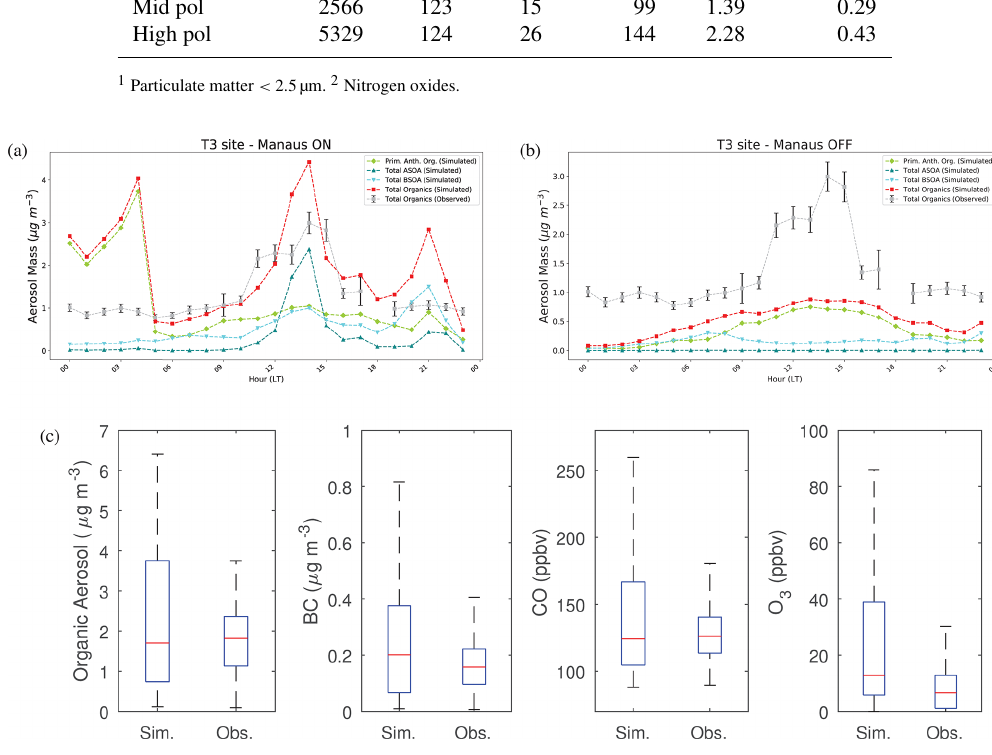
Figure 5. Time series and box plot comparison of measured and WRF-Chem-simulated surface-level gases and aerosols at the T3 site. Contributions from simulated primary anthropogenic organic aerosol (POA), biogenic SOA (BSOA) and anthropogenic SOA (ASOA) to total organic aerosol (OA), as simulated by WRF-Chem, with (a) and without (b) anthropogenic emissions, on 13 March 2014 at the T3 site. (c) Comparison between observed and simulated surface-level gases and aerosols. Box plot of simulated and observed organics, black carbon (BC), carbon monoxide (CO) and ozone (O 3 ) from 9 to 13 March 2014 at the T3 site. Median values are shown in red lines, and the blue box indicates data between the 25th and 75th